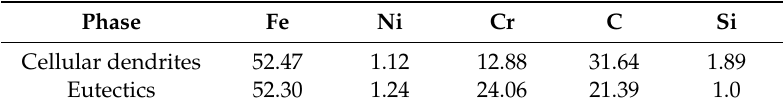
Figure 6. Scanning electron micrograph (SEM) image of Coating 1: ( a ) typical structure of the upper region and ( b ) the magnified morphology of the red rectangle A. Table 3. Chemical composition of different phases examined by energy dispersive spectrometer (EDS) (wt.%).